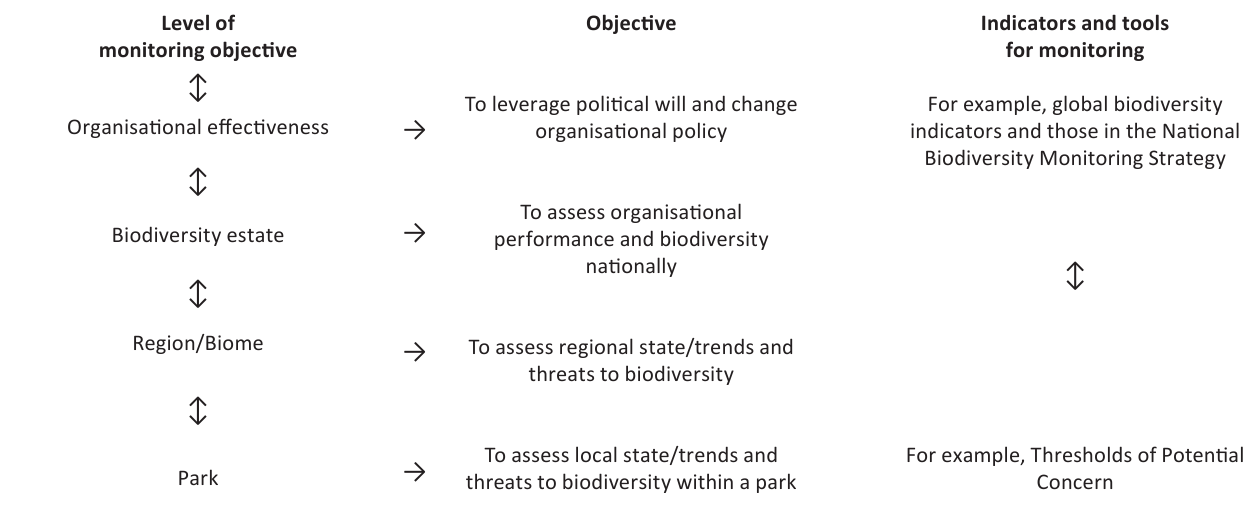
Most of SANParks’ current biodiversity monitoring activities are at park level. Vertical arrows illustrate scaling and integration of objectives and indicators. The ‘biodiversity estate’ is the sum total of the area and its biodiversity, managed by SANParks. Thresholds of Potential Concern (TPCs) are a monitoring endpoint tool that define the upper and lower levels along a continuum of change in selected environmental indicators, and form the operational goals of a park’s objective hierarchy (Biggs & Rogers FIGURE 1: The SANParks Biodiversity Monitoring System (BMS) will address objectives at several levels: organisational, biodiversity estate, regional and park-specific.